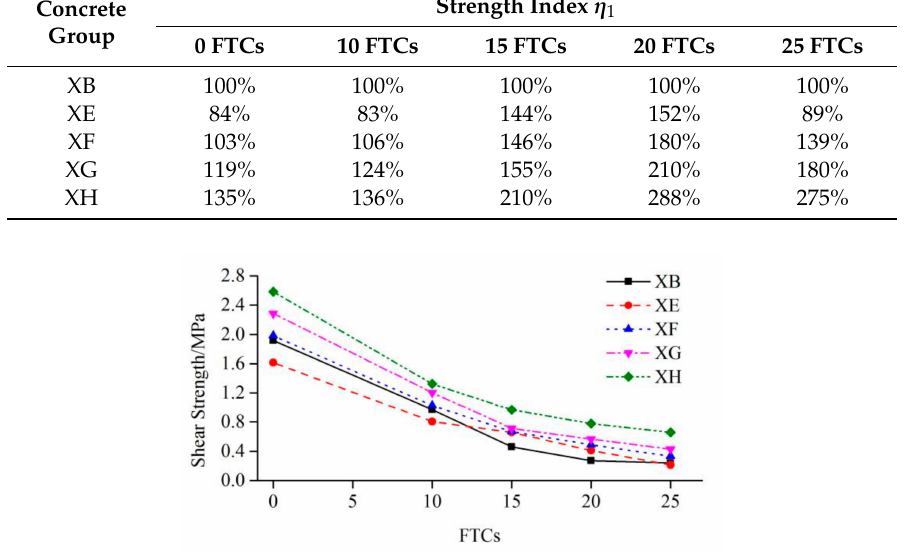
Figure 5. The shear strength versus